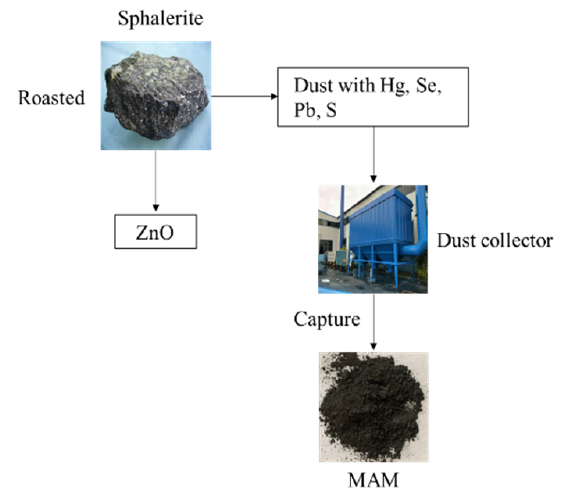
Figure 1. Background process of the production of MAM.